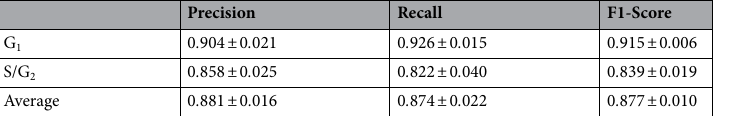
Precision Recall F1-Score G